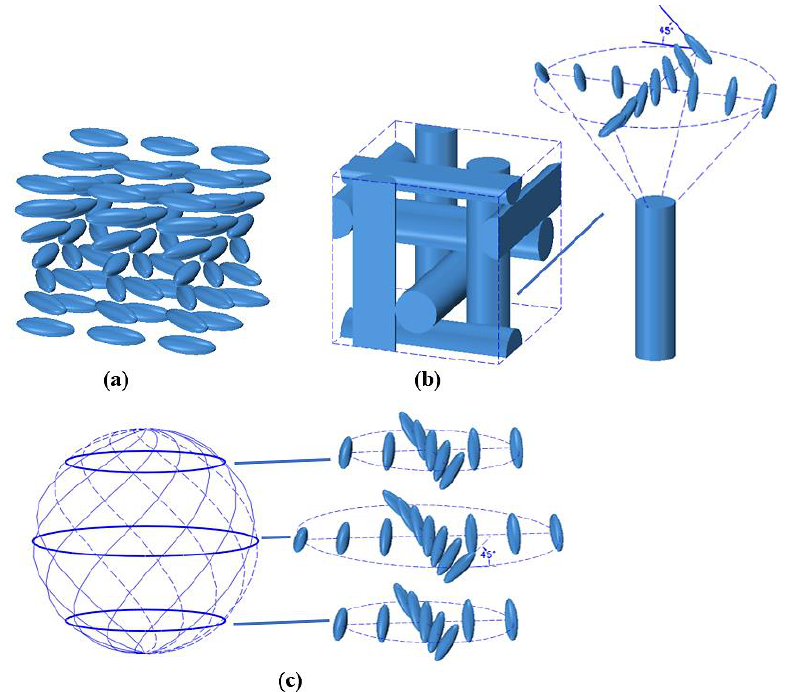
Figure 1. Organization of molecules in ( a ) CLC (planar texture), ( b ) BPLC (BP I), and ( c ) SPLC.